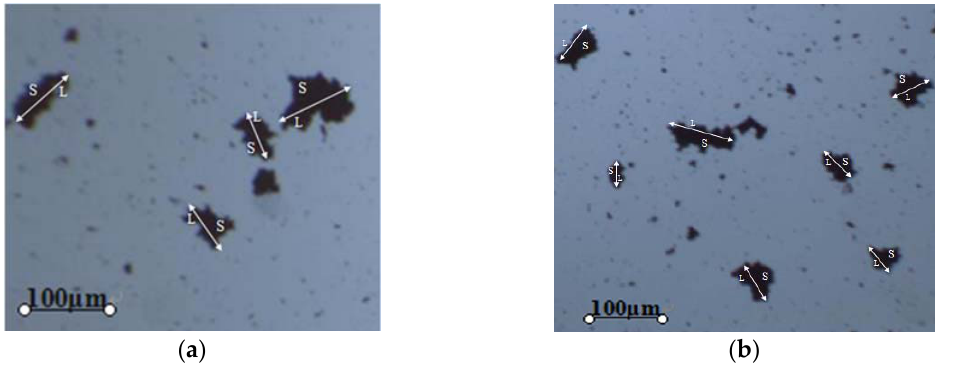
Figure 8. Morphologies of the hematite flocs: ( a ) position 1, ( b ) position 2.